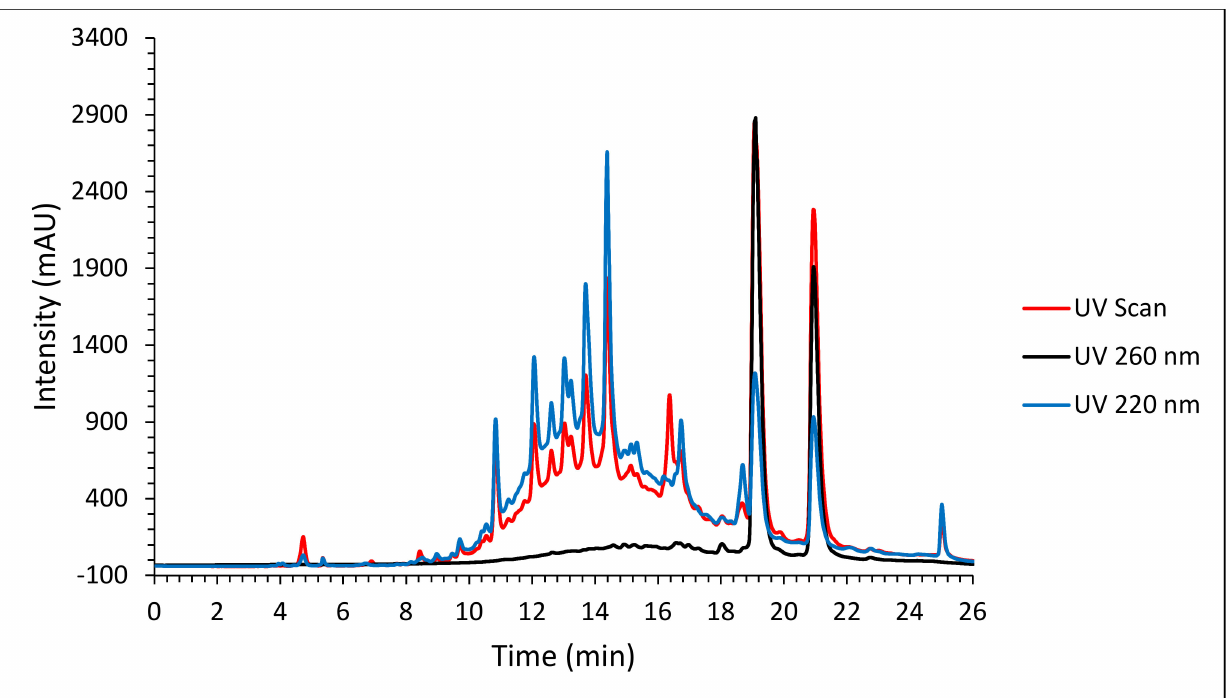
Figure 5. LC-UV max plot chromatogram of Fraction 3 from LC-MS-SPE-NMR. Fractionation of fraction 4 (Fr.4) (100 mg) using semi-preparative